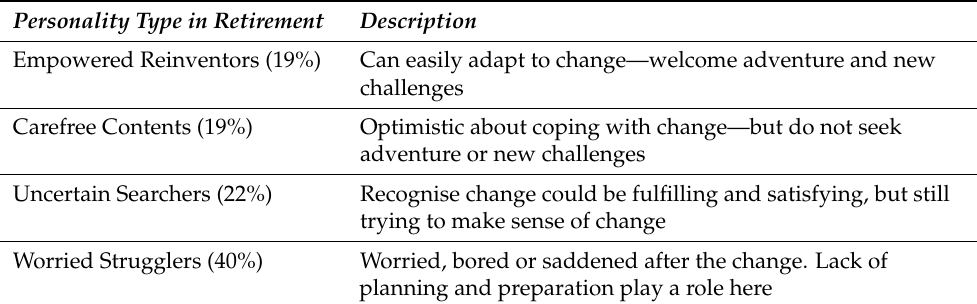
Table 2. Networks based on personality types. Source: The New Retirement Mindscape (Ameriprise Financial, January